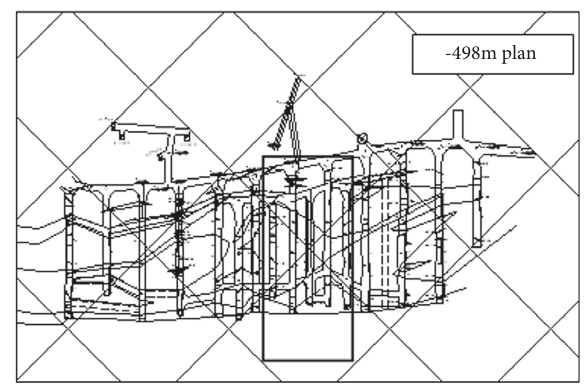
Figure 2: Planar graph at the buried depth of 498m of the